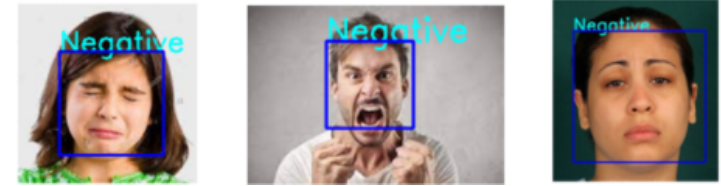
Figure 23. Accurately Classified Images 3 × Negative.